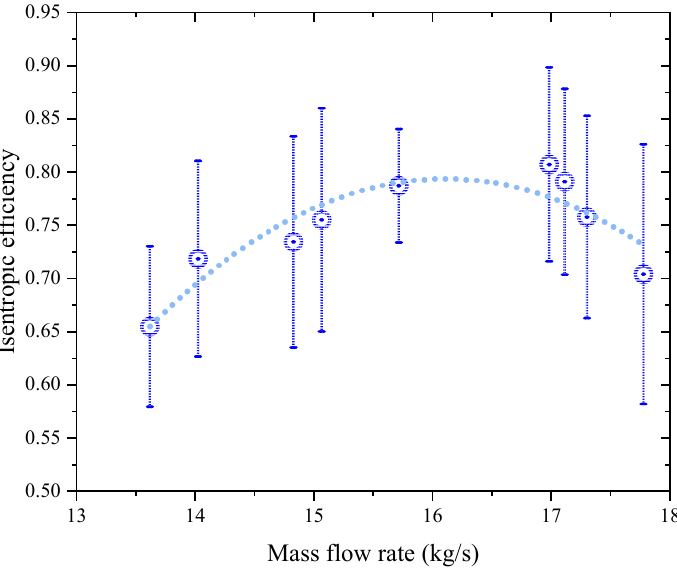
Figure 11. Isentropic efficiency performance curve (@ 31,000 ± 1000 RPM).